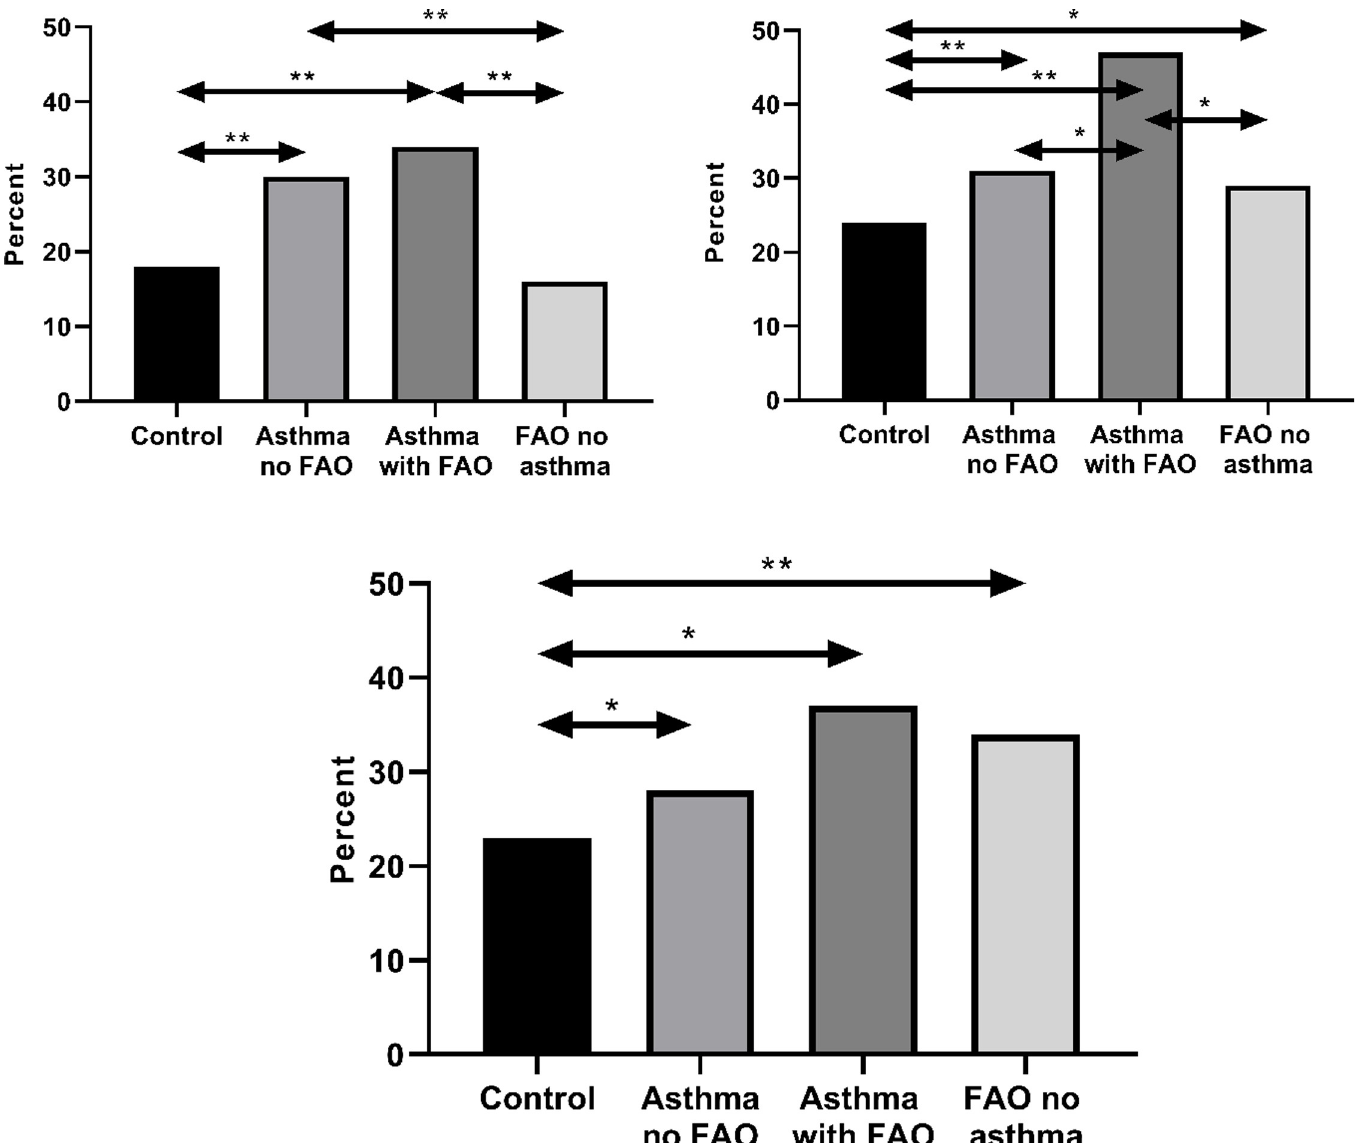
Fig 2. Percent with elevated marker in the groups respectively: Panel a: FeNO; panel b: B-Eos; panel c: B-Neu. (a) Percent with elevated FeNO ( � 25ppb) in the groups: Control: 17%, Asthma without FAO: 29%, Asthma with FAO: 33%, FAO without asthma: 16%, �� p < 0.001. (b) Percent with elevated B-Eos ( � 300 cells/ μ L) in the groups: Control: 23%, Asthma without FAO: 30%, Asthma with FAO: 48%, FAO without asthma: 30%, � p < 0.05, �� p < 0.001. (c) Percent with elevated B-Neu (B-Neu � 5100 cells/ μ L) in the groups: Control: 23%, Asthma without FAO: 29%, Asthma with FAO: 35%, FAO without asthma: 34%, � p < 0.05, �� p < 0.001. Abbreviations: FeNO: fraction of exhaled Nitric Oxide, B-Eos: blood eosinophils, B-Neu: blood neutrophils, FAO: fixed airflow obstruction.